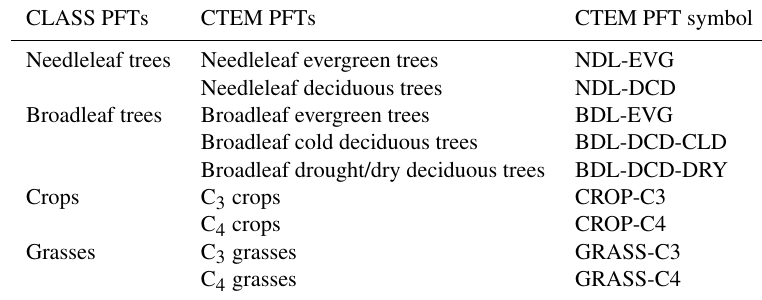
Table 1. Plant functional types (PFTs) represented in CTEM and their relation to CLASS PFTs. CLASS PFTs CTEM PFTs CTEM PFT symbol Needleleaf trees Needleleaf evergreen trees NDL-EVG Needleleaf deciduous trees NDL-DCD Broadleaf trees Broadleaf evergreen trees BDL-EVG Broadleaf cold deciduous trees BDL-DCD-CLD Broadleaf drought/dry deciduous trees BDL-DCD-DRY Crops C 3 crops CROP-C3 C 4 crops CROP-C4 Grasses C 3 grasses GRASS-C3 C 4 grasses